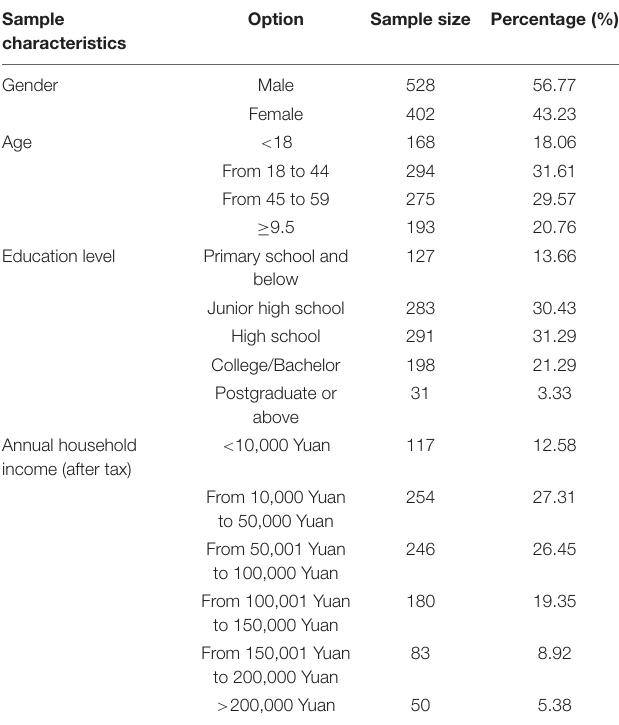
TABLE 1 | Socio-demographic characteristics of the sample ( n = 930). Sample